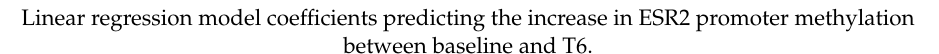
Table 5. Linear regression model coefficients predicting the increase in ESR2 promoter methylation between baseline and T6. B CI 95% Beta p CA repeats 1.400